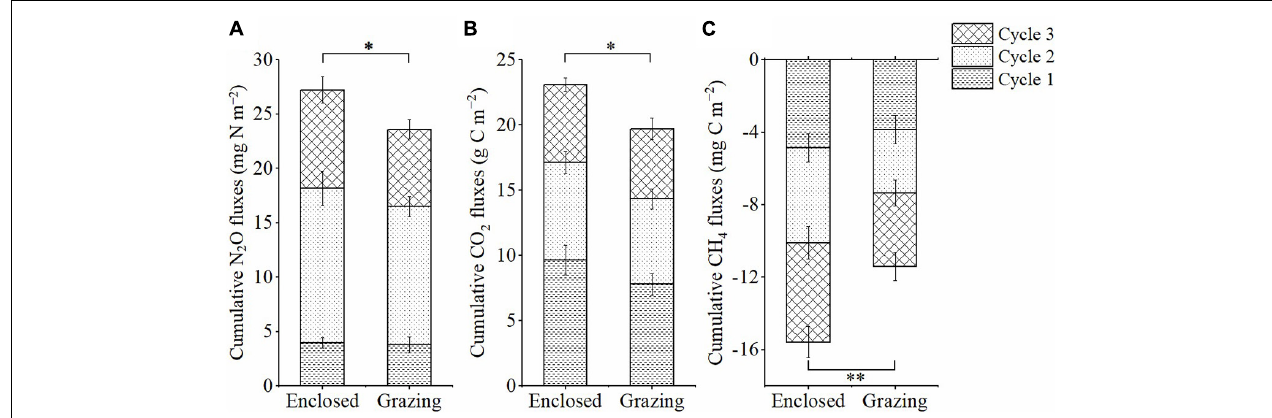
TABLE 2 | Two-way ANOVA of the effects of FTCs, grazing and their interaction on soil N 2 O, CO 2 and CH 4 fluxes during FTCs. P -values N 2 O CO 2 CH 4 FTCs < 0.001 < 0.001 < 0.001 Grazing 0.284 0.004 < 0.001 FTCs * Grazing 0.512 0.048 < 0.001 Significant effects (P < 0.05) are highlighted in